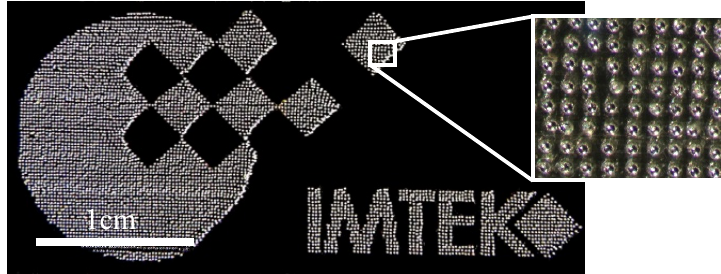
Figure 14. Picture of a DoD-mode printed affiliation logo of the IMTEK; droplet diameter approx. 88 μ m.